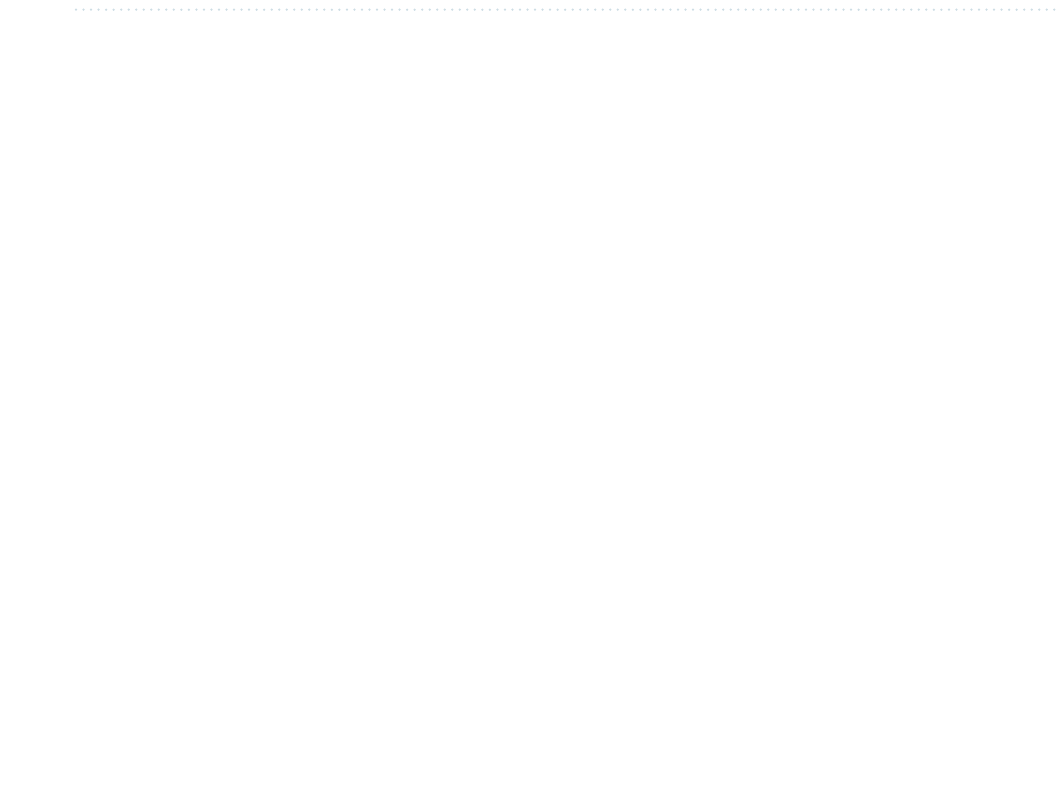
Figure 5. Non-local correlations for α 1 1 0 ϕ in the absence of the intrinsic decoherence with ( n x , n y ) √ 2 [| ↑ | � = � + | ↓ �] n x n y 7 in ( b = =